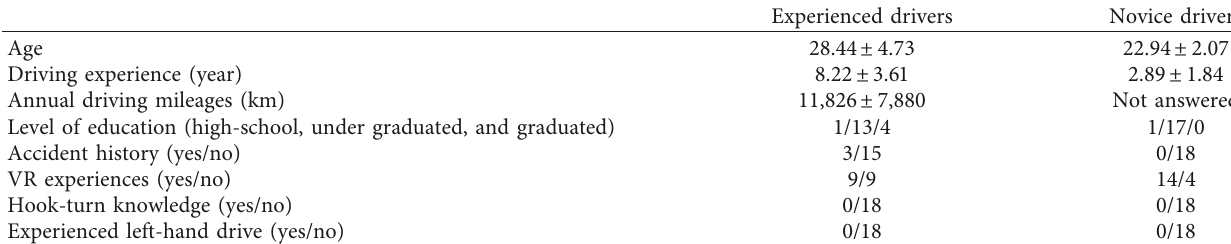
Table 1: Participants’